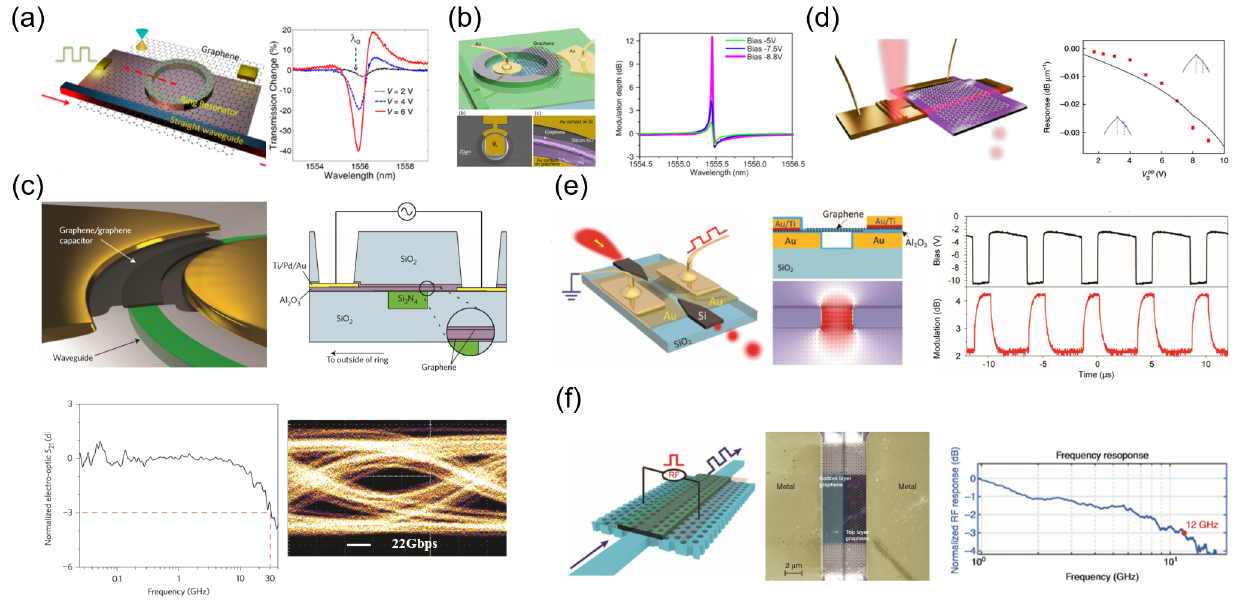
Figure 5. Graphene EA modulators based on micro − resonators. ( a ) Schematic diagram of graphene- modulated silicon microring modulator and gate-voltage-induced differential transmission spectra at different voltages [61]. Reproduced from Ref. [61] with permission. ( b ) The 3D schematic image of the graphene-silicon microring resonator and the corresponding modulation depth of graphene-silicon microring with quarter-coverage by graphene for different bias voltage on graphene [62]. Reproduced from Ref. [62] with permission. ( c ) Schematic of the EA modulator consisting of a GOG capacitor integrated along a Si 3 N 4 ring resonator and cross-section of the device. Electro-optic S21 frequency response displays clear RC-limited 30 GHz bandwidth. Open 22 Gbps NRZ eye diagram [27]. Reproduced from Ref. [27] with permission. ( d ) Left: 3D rendering of the first graphene plasmonic EO modulator with guided wedge plasmon mode. Right: Modulated AC (6 Hz) transmission per µ m of the device as a function of AC peak-to-peak amplitude for the wedge plasmon mode [63]. Reproduced from Ref. [63] with permission. ( e ) 3D schematic and cross-section of the graphene- plasmonic slot hybrid modulator and the plasmonic slot waveguide mode profile. Measured optical square waveform signal operating at 200 kbps with an on–off ratio of 2.1 dB [64]. Reproduced from Ref. [64] with permission. ( f ) Structure of the DLG on photonic crystal waveguide EA modulator and its SEM image. Frequency response of the modulator shows a 3 dB-bandwidth of 12 GHz [32]. Reproduced from Ref. [32] with